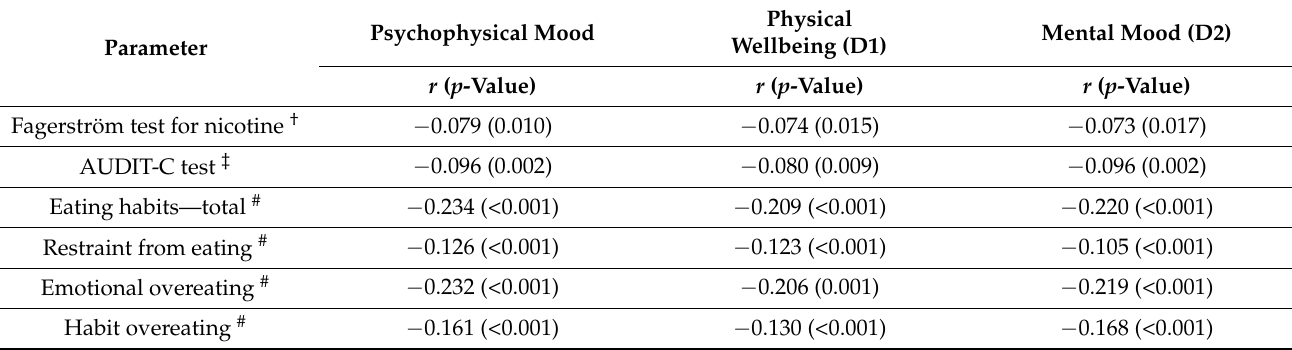
The correlations between psychophysical wellbeing and nicotine dependence, alcohol